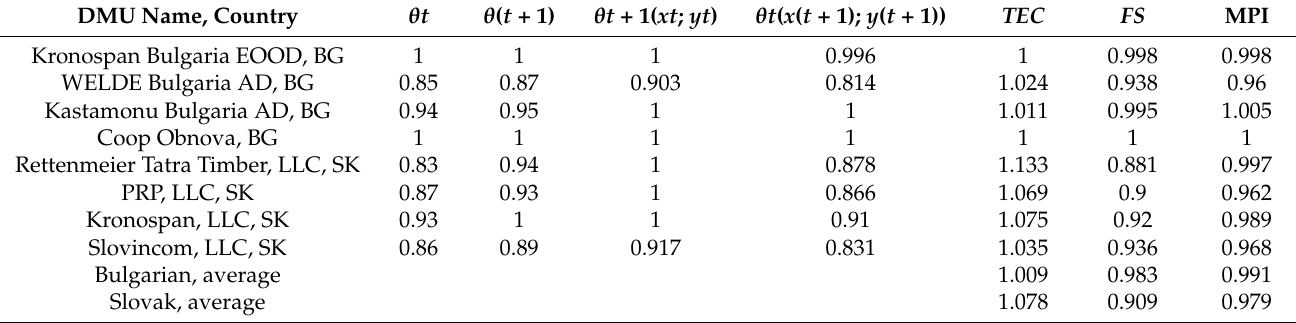
Table 7. MPI results for CCR with labour and materials costs as inputs, t = 2014, t + 1 =